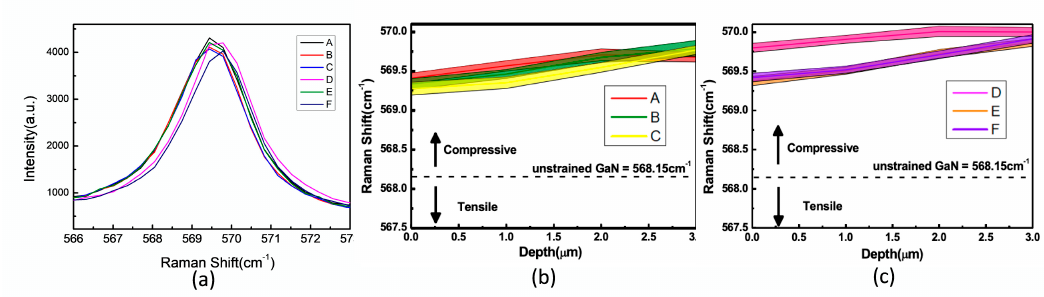
Figure 3. ( a ) Zoomed-in view of the E 2 high Raman peaks of all samples. Raman peak shifts of the GaN E 2 high phonon modes of ( b ) samples A / B / C (with large V-pits, typically 569.2–569.4 cm − 1 at surface) and ( c ) D / E / F (with small V-pits, typically 569.4–569.8 cm − 1 at surface) plotted as a function of the depth of the LED structure from the surface (0 µ m) toward substrate.